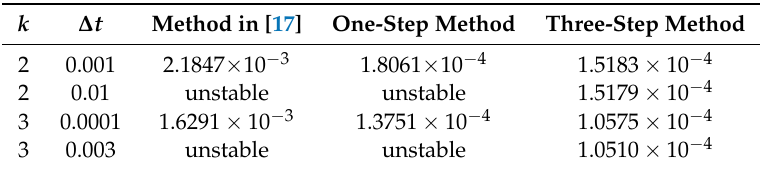
Table 1. The L ∞ error of Example 1 in M = 6.